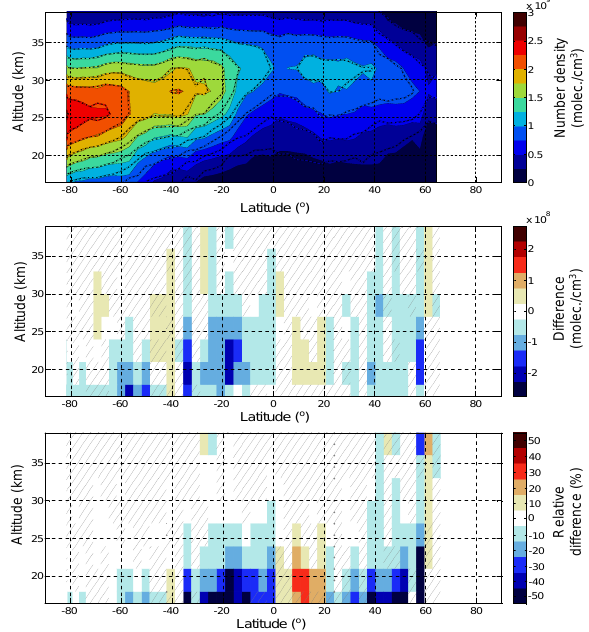
Fig. 6. Top panel: vertical and latitudinal distribution of the mean NO 2 number density for all six full limb orbits on 14 December 2008 retrieved by the 2-D approach (color plot with solid con- tourlines) and the 1-D approach (dashed contourlines). Middle and bottom panels: absolute and relative difference between results from the 1-D and 2-D approach for the retrieval boxes. Boxes where the retrieval error is larger than the difference are shaded by a diag- onal pattern.